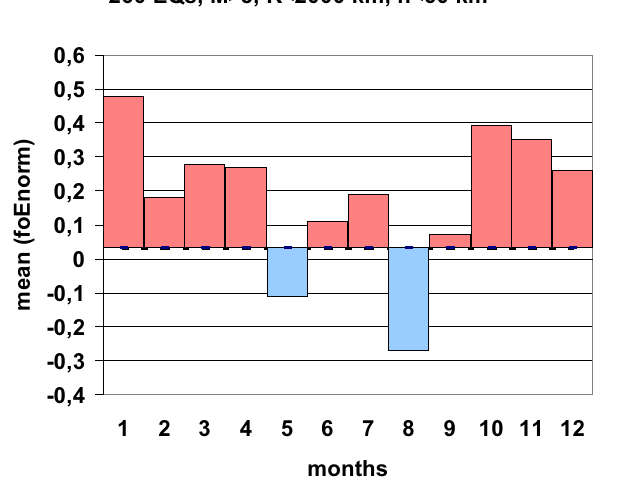
Fig. 4. Variations of foE norm on the day (-1) of all winter- earthquakes in dependence on the year. Every earthquake is pre- earthquakes in dependence of the year. Every earthquake is pre- sented by a triangle. It is to be seen, that in all the years the number Fig. 2. Seasonal dependence of foEnorm one day before an earth- earthquakes in dependence of the year. Every earthquake is pre- sented by a triangle. It is to be seen, that in all the years the number of earthquakes with foEnorm larger than the mean value is larger quake shown by its monthly average values. The dash-dotted line Fig. 2. Seasonal dependence of foE norm one day before an earth- than the number of seismic shocks with foEnorm smaller than the sented by a triangle. It is to be seen, that in all the years the number presents the mean value for all days ( − 1) of all data considered. of earthquakes with foE norm larger than the mean value is larger Fig. 2. Seasonal dependence of foE norm one day before an earth- quake shown by its monthly average values. The dash-dotted line of earthquakes with foE norm larger than the mean value is larger than the number of seismic shocks with foE norm smaller than the quake shown by its monthly average values. The dash-dotted line presents the mean value for all days (-1) of all data considered. than the number of seismic shocks with foE norm smaller than the average. presents the mean value for all days (-1) of all data considered. average.